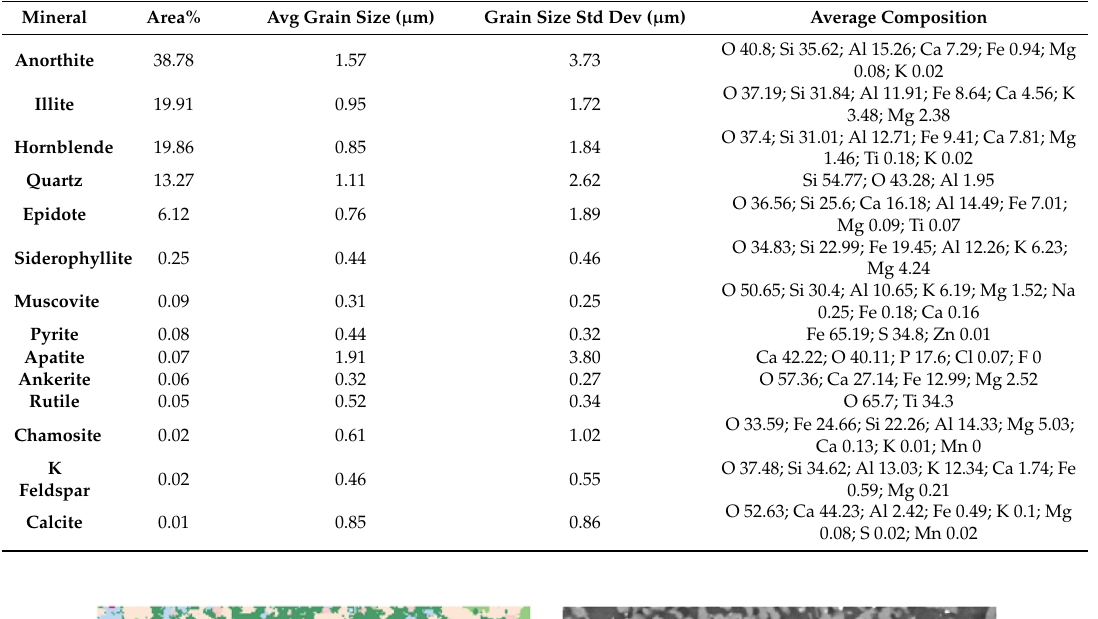
Table 1. Modal mineralogy data from the selected region of interest displayed in the graphical abstract. This data displays the mineral, its area % occurrence in the sample, the average grain size of that mineral with its standard deviation, and its average composition in wt.%.